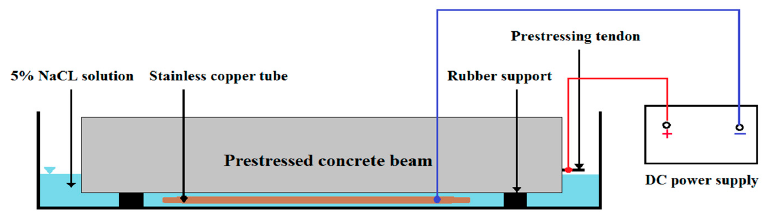
Figure 4. Accelerated corrosion of the prestressed concrete beams.